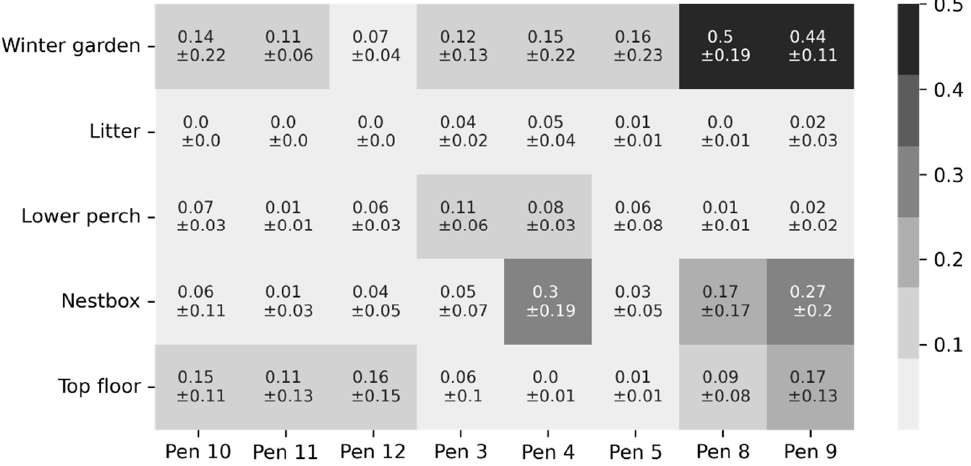
Figure 5. Estimated error rate (mean ± SD) for pen-zone areas.